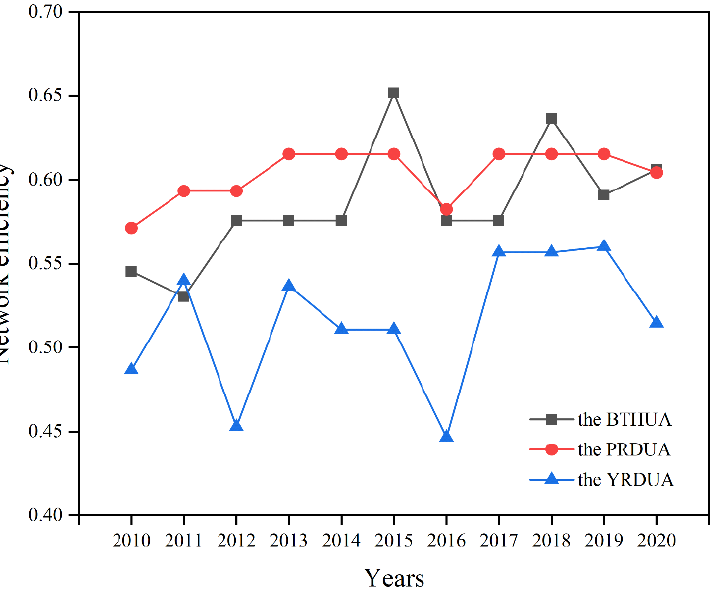
Figure 5. Network efficiency of housing prices’ association network in the BTHUA, the PRDUA, and the YRDUA from 2010 to 2020.